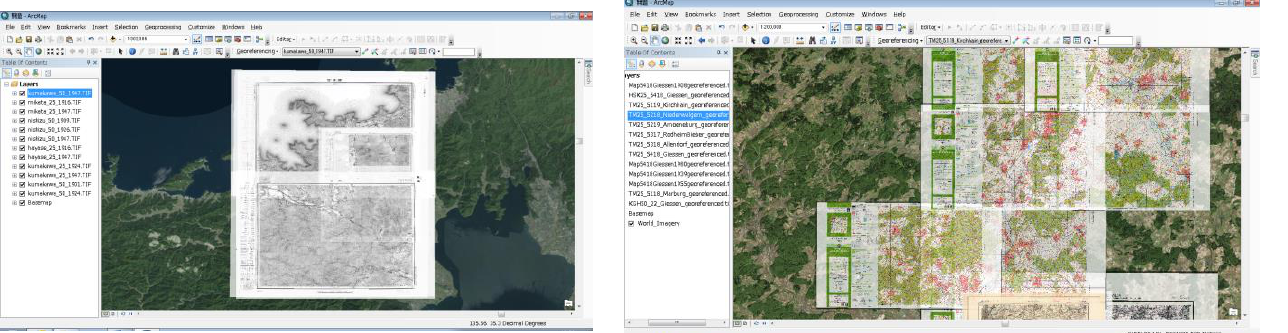
Figure 16. Overlay of Old Edition Map: Topographic Map (Japan) in ArcGIS Online